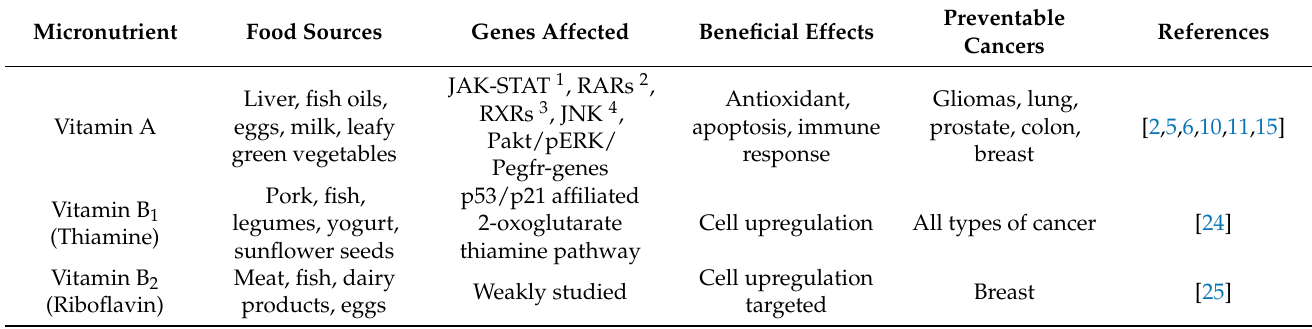
Table 1. Summary of the nutrigenomic effects of micronutrients on the potential for prevention of